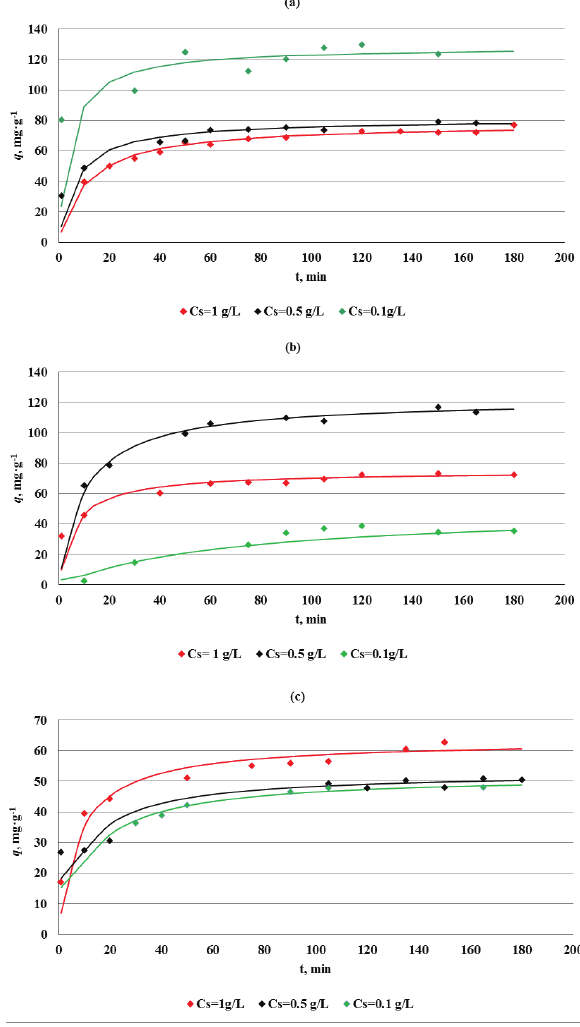
Figure 3. The kinetics of biosorption of Cr(III) ions at different pH of solution ( C S 1.0 g·L -1 , Figure 2: The kinetics of biosorption of Cr(III) ions at different 300 mg·L -1 ) contents of biosorbent (a) pH 5, 300 mg·L -1 , (b) pH 5, 200 mg·L -1 ; (c) pH 5, 100 mg·L -1